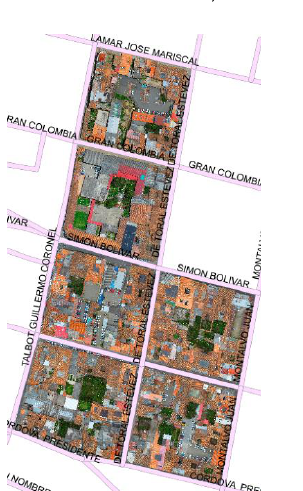
Source: Municipalidad de Cuenca, 2016